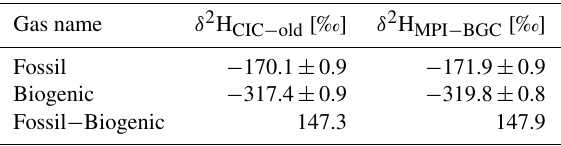
Table 5. Comparison of δ 2 H results between CIC and MPI-BGC. Indices of the header are explained in Sect. 2.9 of the main text. The uncertainty of all data includes the full traceability chain (Sect. 2.4), which includes revised uncertainties of the CIC data (Sect. 2.9). The difference Fossil − Biogenic allows us to compare scale compres- sion effects between both methods.